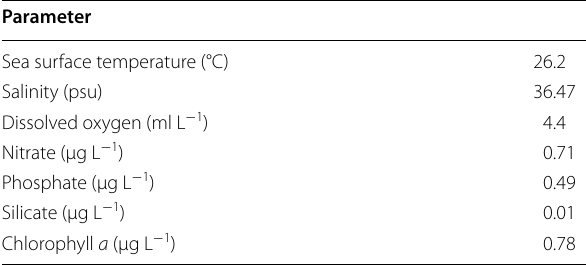
Table 1 Physicochemical parameters of the area where the apostome ciliate, Vampyrophrya pelagica, was observed in copepod Bestiolina